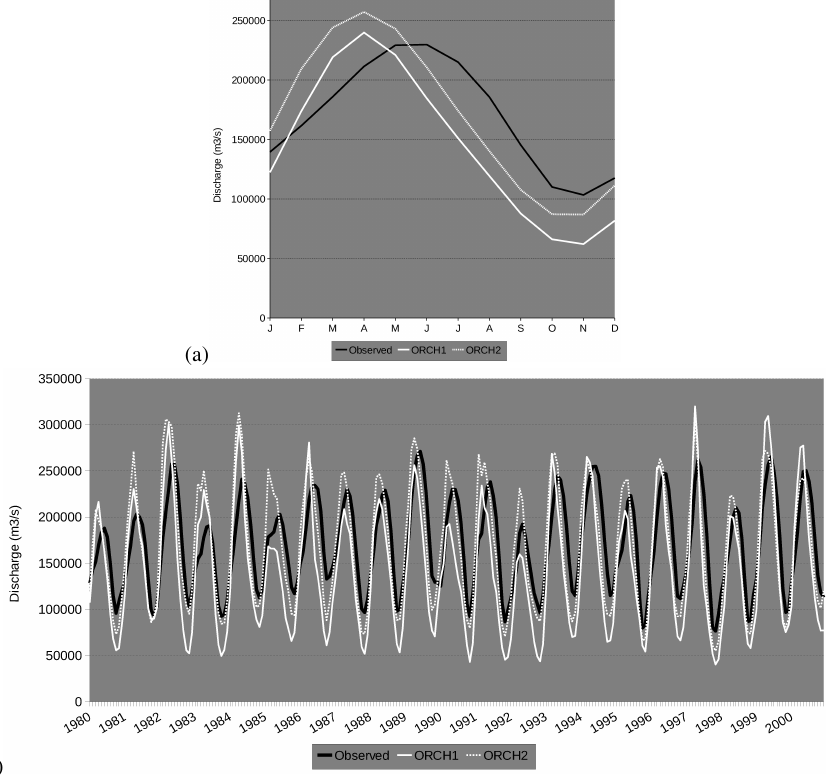
Fig. 10. Mean monthly discharge (m 3 s − 1 ) at ´Obidos for simulations ORCH1 and ORCH2 compared to observations. (a) Mean annual seasonality and (b) interannual variation over the time period 1980–2000.